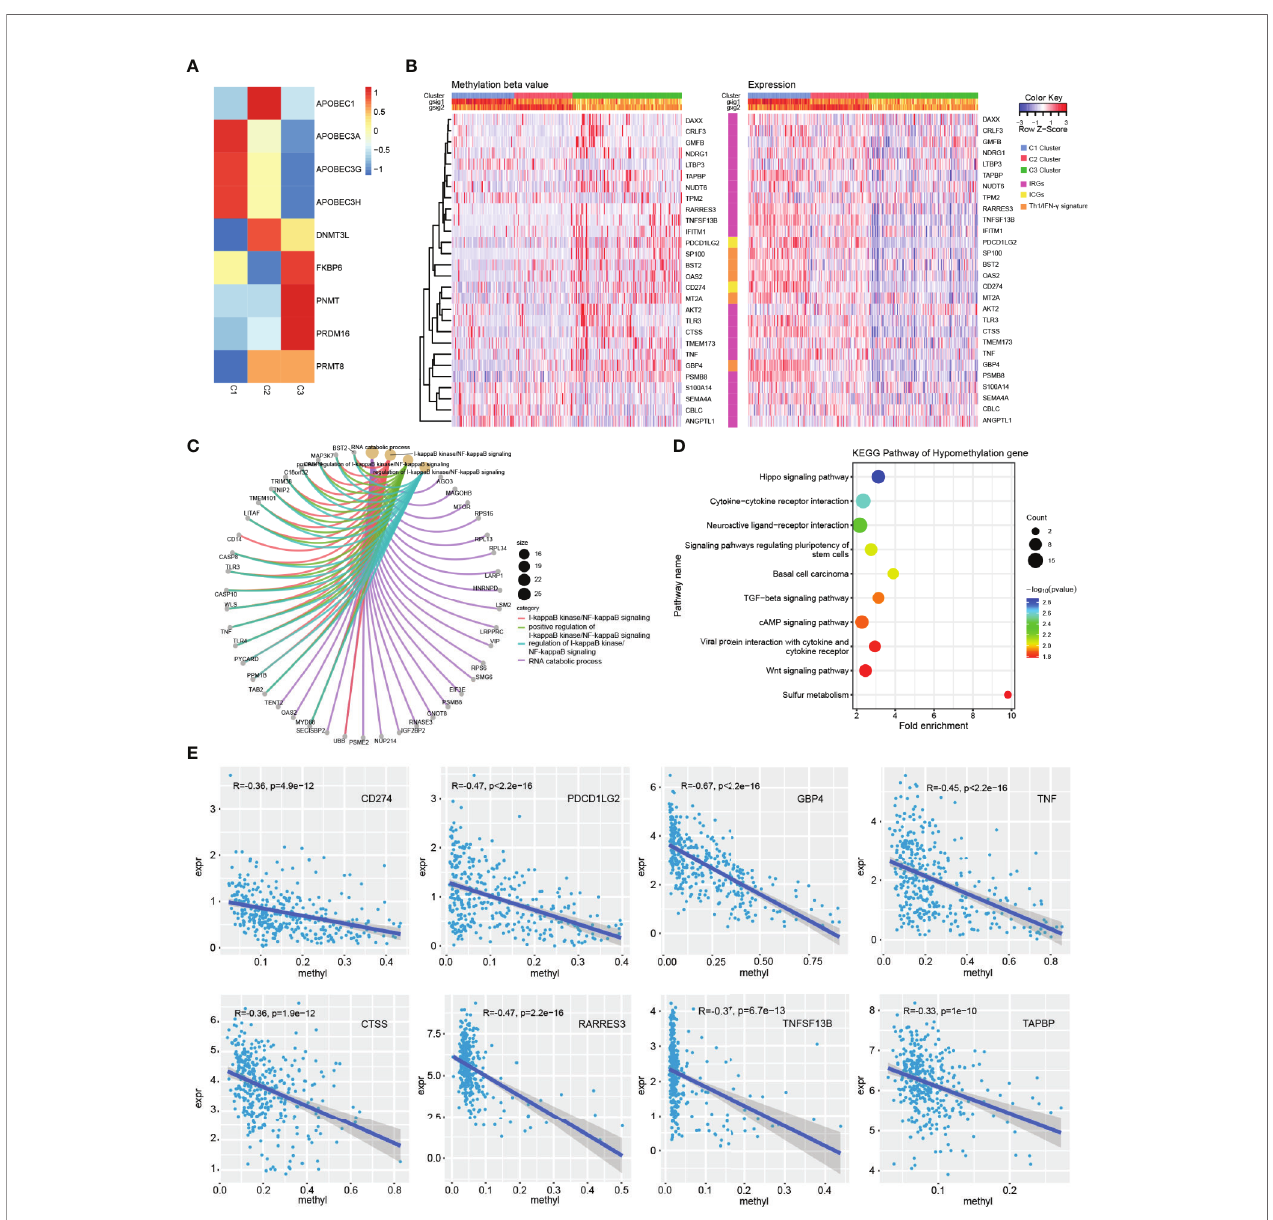
FIGURE 8 | Methylation analysis of immune subtypes. (A) Expression differences of methylation related genes in three immune subtypes. (B) Heatmap of genes with signi fi cant differences in methylation and transcriptional expression among subtypes. (C) GO enrichment analysis of hypermethylated genes in C3 subtype. (D) KEGG pathway analysis of hypomethylated genes in C3 subtype. (E) Correlation trend of methylation level and transcription expression of immune related